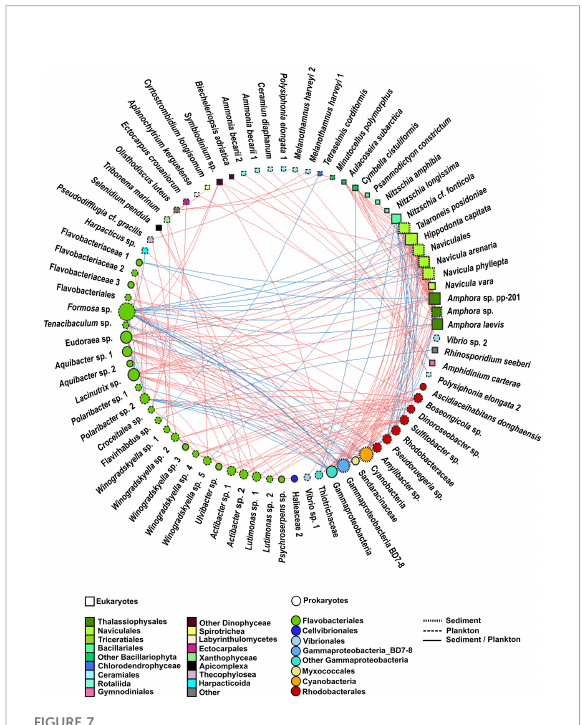
FIGURE 7 Undirected network that represents all the links among organisms (prokaryote – prokaryote, eukaryote – eukaryote, and eukaryote – prokaryote). Signi fi cant co-occurrences or co- exclusions (p value <0.01) were represented with a Spearman r > 0.7. Red edges represent positive correlation (co-occurrences), whereas blue edges represent negatives (co-exclusions). The size and colour of the nodes represent the degree and taxonomic group, respectively. The shape of nodes represents whether the organism is a eukaryote (square) or prokaryote (circle). The type of node lines represents the environmental compartment (sediment, plankton, or both of them) on which each OTU is more representative in terms of percentage of total prokaryotic